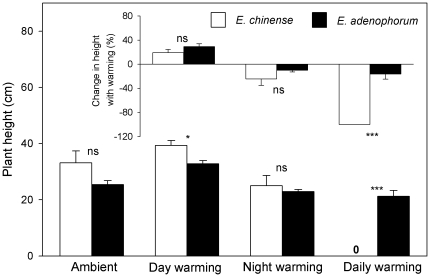
Plant height of the invasive plant Eupatorium adenophorum and the native plant Eupatorium chinense grown in four different air temperatures, and changes in plant height with warming for both species (embedded smaller panel inside).Data are means+1 SE. ns = not significant; * P<0.05; *** P<0.001.